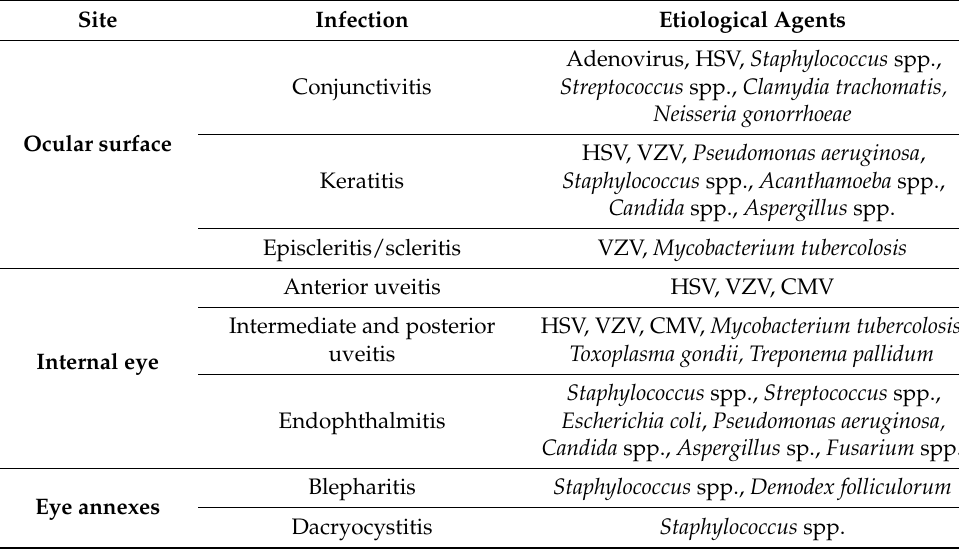
Table 1. Sites of ocular infections and associated etiological